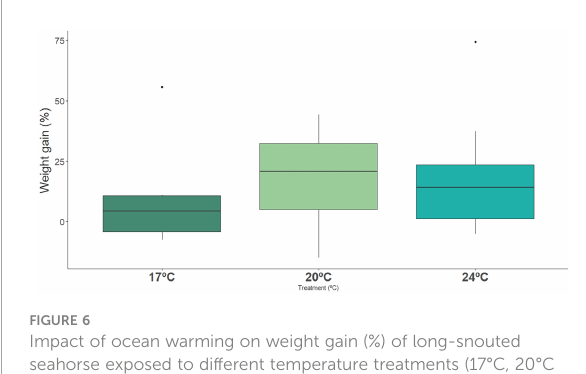
FIGURE 4 Time spent attached (s -1 ) by long-snouted seahorse exposed to different temperature treatments (17°C, 20°C and 24°C). Bold * represent signi fi cant differences from control treatment.